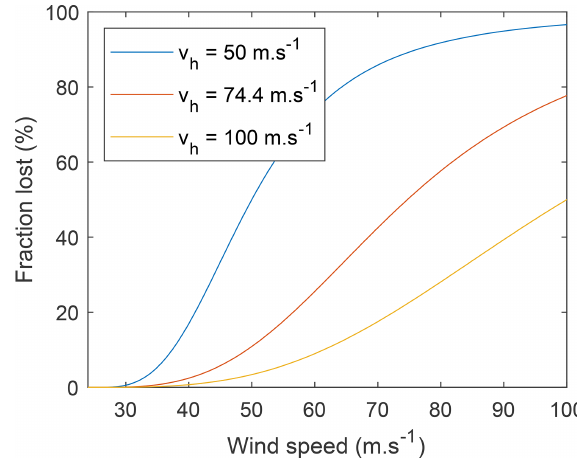
Figure 18. Fraction of property value lost as a function of wind speed (ms − 1 ), obtained using Eq. (18) with different values of v h . Source: Emanuel